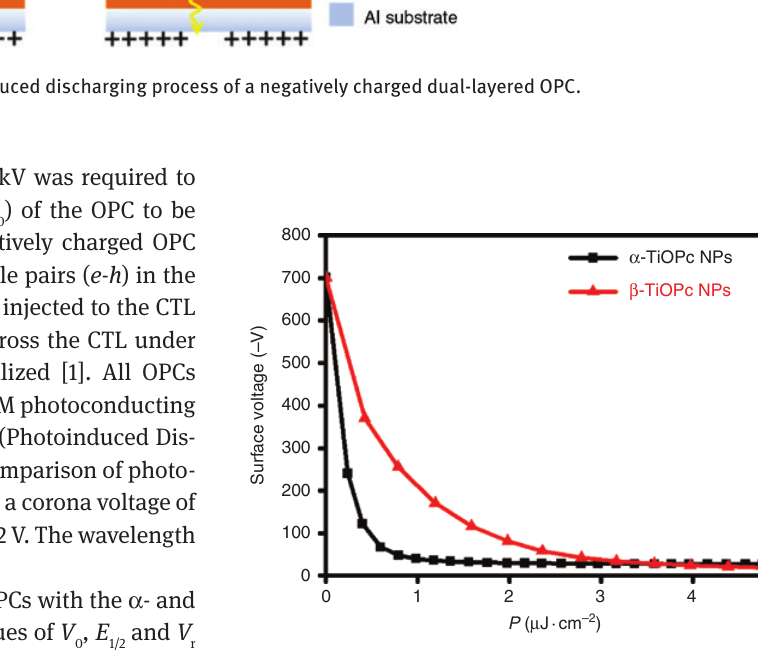
Figure 5: The PIDCs of the OPCs containing the α -TiOPc NPs (black) and β -TiOPc NPs (red) as charge generation materials